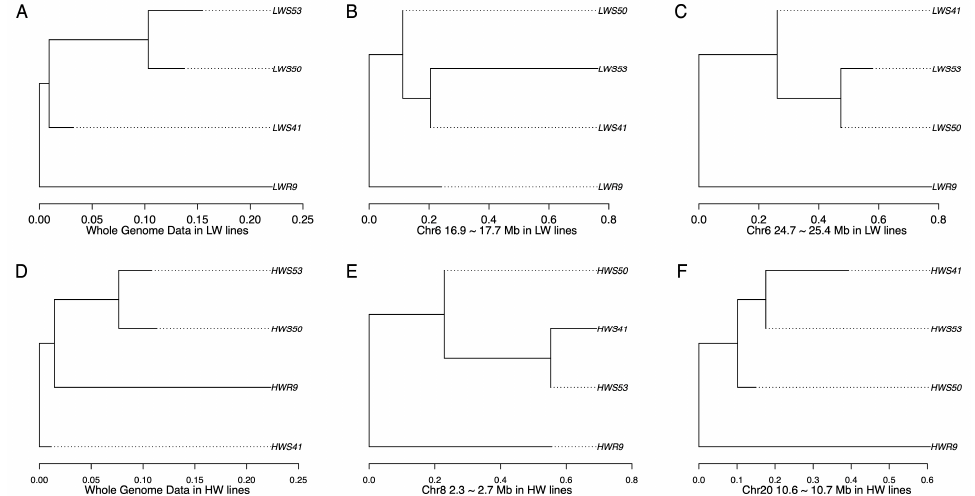
Figure 2. Genome-wide and regional hapFLK trees identifying purging in the HW and LW